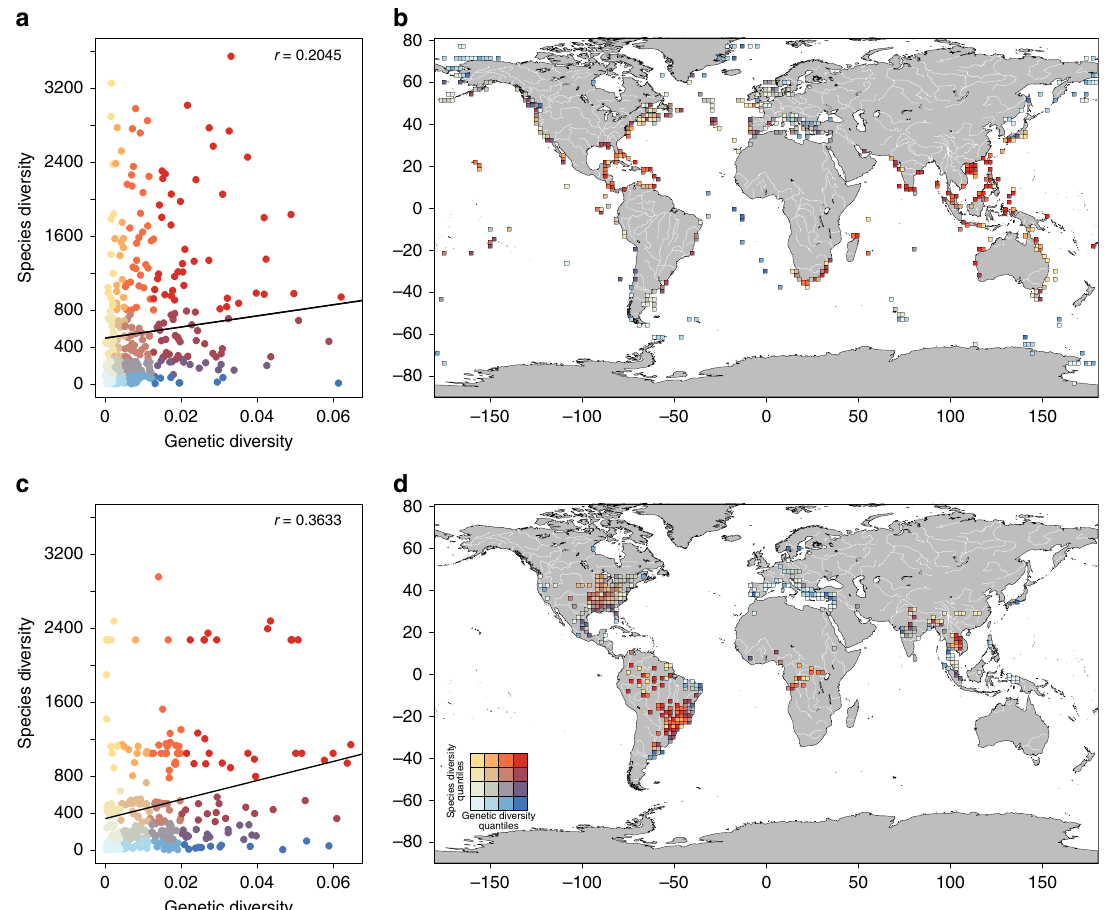
Fig. 2 Congruence between fi sh genetic and species diversity. Classi fi cation of cells depending simultaneously of their values of genetic and species diversity for marine ( a ) and freshwater ( c ) species. Values of diversity were reported on the global map using a colour gradient depending on the values of the genetic and species diversities for marine species ( b ) and freshwater species ( d ) respectively. The colour scale of Fig. 2a – d is de fi ned in the Fig. 2d. The line was represented as the output of a linear model (lm) of the correlation between genetic diversity and species diversity. Person coef fi cient of correlations calculated in linear regressions ( r ) are reported on the fi gure. Drawn with R version